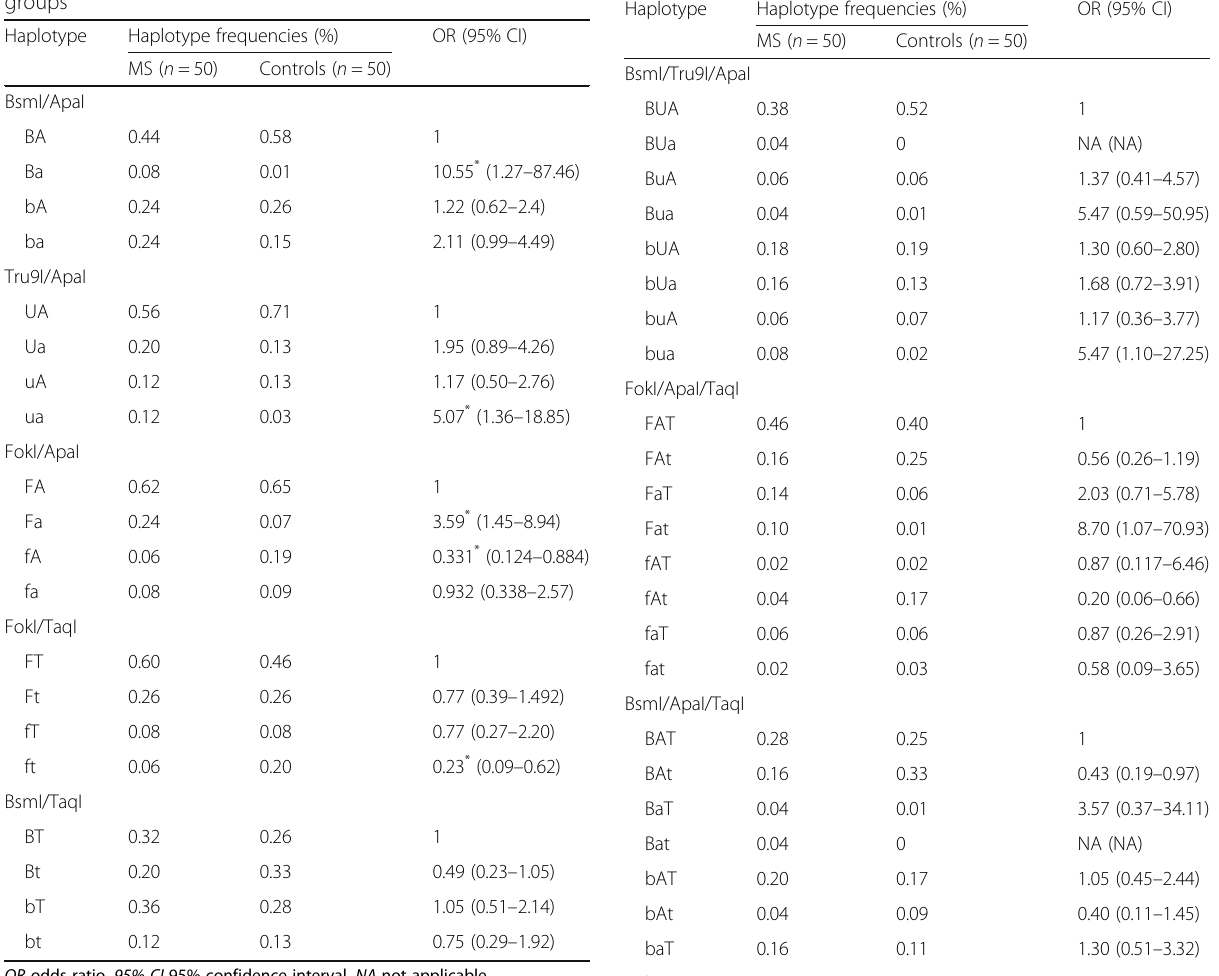
Table 4 Association of biallelic haplotypes BsmI/ApaI, Tru9I/ ApaI, FokI/ApaI, FokI/TaqI, and BsmI/TaqI in the two study groups